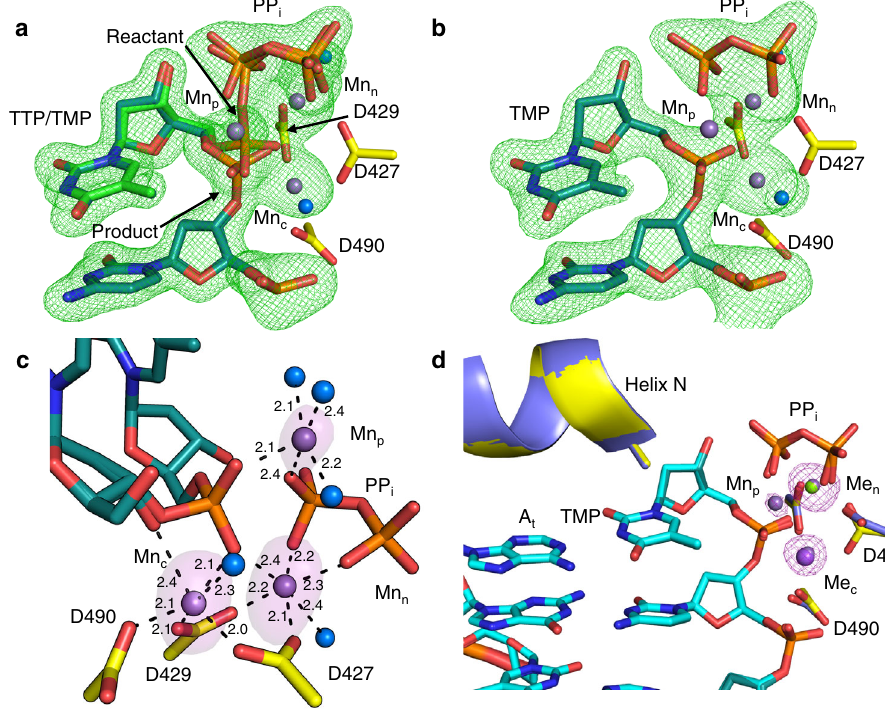
Fig. 6 Manganese-mediated insertion and the product metal. a Matched (TTP:A t ) Mn 2 + -reaction state (RS Mn ) complex after a 5 min soak. Partial nucleotide insertion with inversion about P α and concurrent generation of PP i are evident from the simulated annealing (F o -F c ) omit density shown at 3 σ (green mesh), carve radius 2.0 Å. Product formation is accompanied by the appearance of an additional metal (Mn p ). Active site aspartates are shown in yellow stick representation, the incoming nucleotide is in green, DNA in cyan. Mn 2 + atoms are shown as magenta spheres, water molecules in blue. b Matched Mn 2 + -product state after a 20 min soak. Mn p is still present (F o -F c density omitted for clarity). Simulated annealing omit (F o -F c ) density (green mesh) shown is contoured at 3 σ , carve radius 2.0 Å. c Active site metal coordination and anomalous density in the Mn 2 + -reactant state. Anomalous density is shown as a magenta surface at 5 σ , carve radius 2.0 Å. Metal coordination is shown with dashes, coordination distances (Å) are indicated. dCTP was omitted for clarity. d Structural overlay of the Mg 2 + (purple protein, light cyan DNA) and Mn 2 + (yellow protein, dark cyan DNA) product complexes. Anomalous density (magenta mesh) is shown contoured at 5 σ , carve radius 2.0